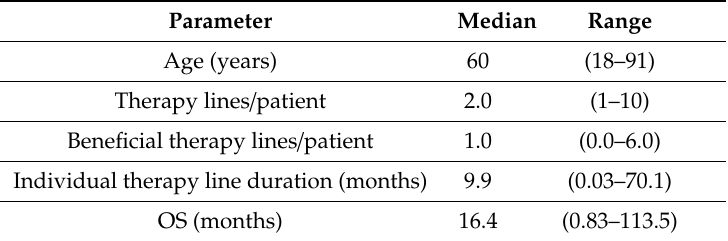
Table 1. Summary of demographics, treatment line, and overall survival (OS) data of the cohort of 194 metastatic renal cell carcinoma (mRCC) patients.